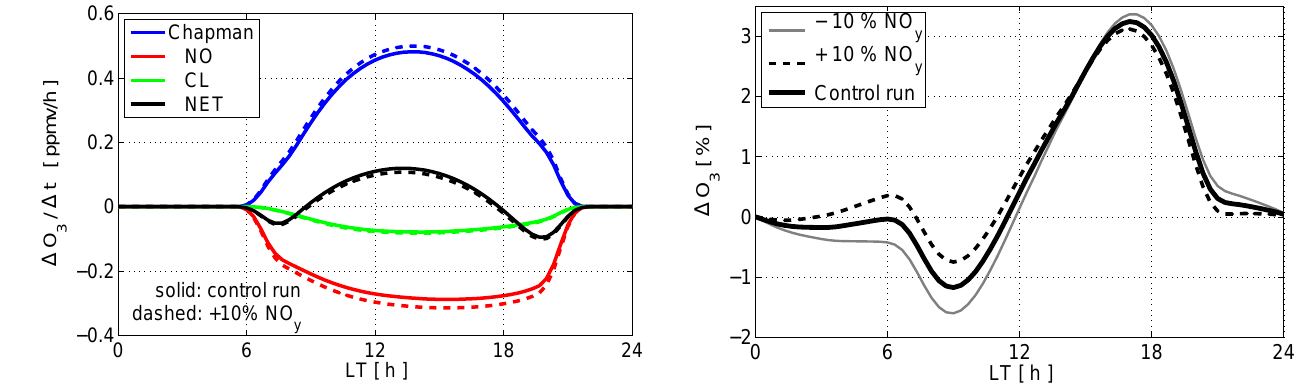
Figure 9. Zonal-mean conversion rates of ozone derived from a sim- Figure 10. Daily ozone cycles derived from simulations with ulation with 10% more initial NO y concentration and a control sim- ± 10% initial NO y concentration and a control simulation shown ulation on 1 January, 5hPa, 22 ◦ N. for 1 January, 5hPa, 22 ◦ Table 1. Relation of D T and D O in the tropics. The anomalies with 3 respect to the tropical mean are given by D 0 and D 0 . Regions T O 3 A and B are indicated in Fig. 7c.